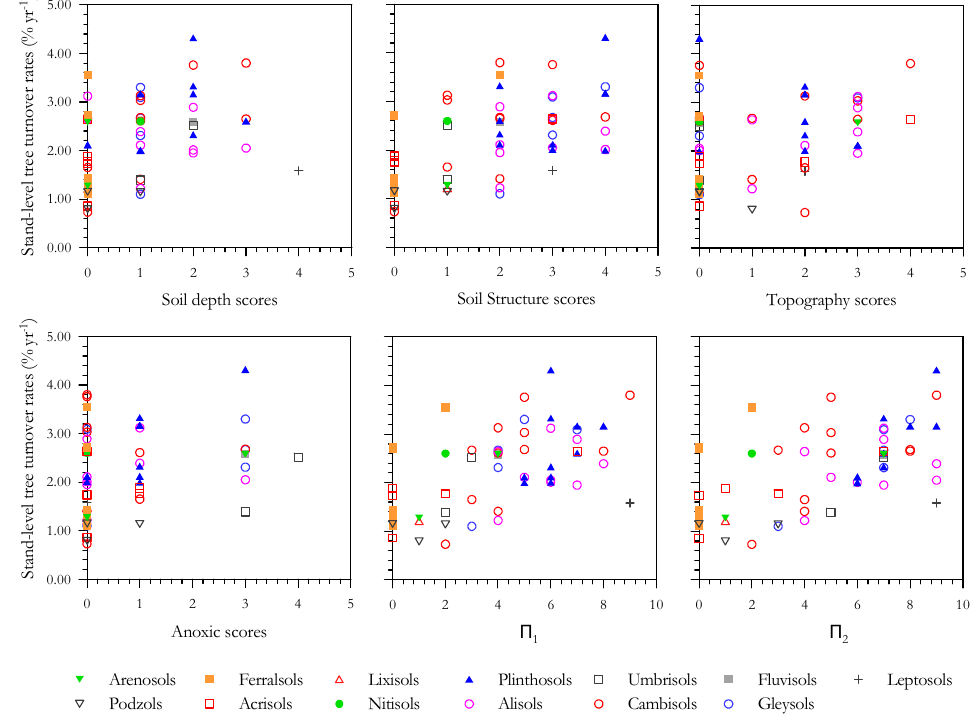
Fig. 10. Relationships between tree turnover rates and soil physical properties. For definitions of 5 1 and 5 2 see Sect. 2.2.